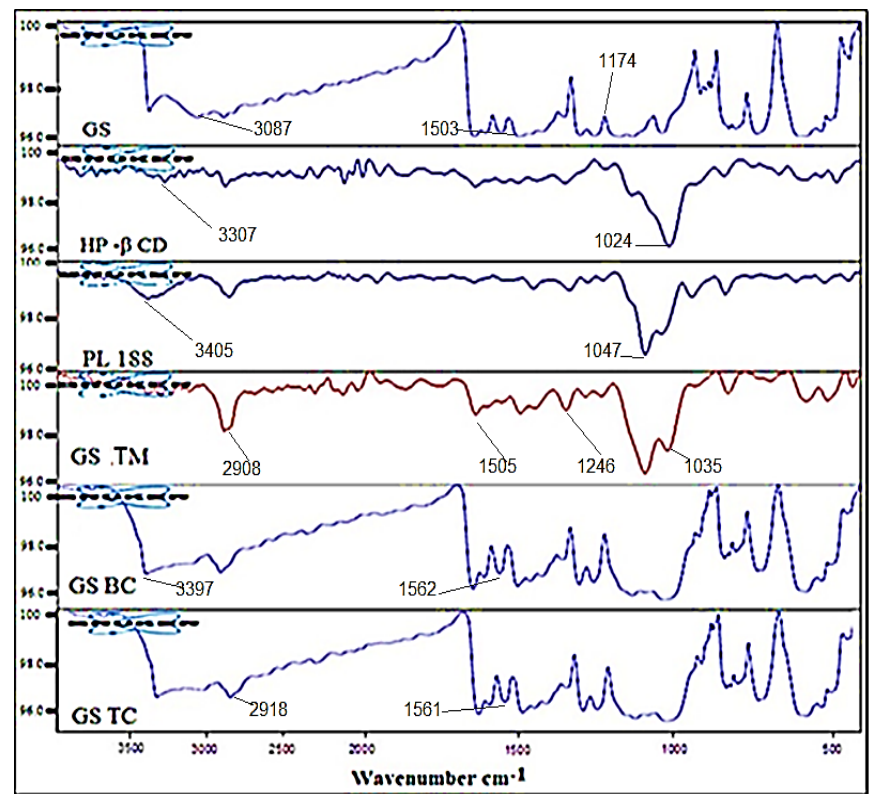
Figure 5. IR spectra of Genistein (GS), HP- β Cyclodextrin (HP- β CD), poloxamer 188 (PL 188), genistein ternary mixture (GS-TM), genistein binary complex (GS-BC), genistein ternary complex (GS-TC).